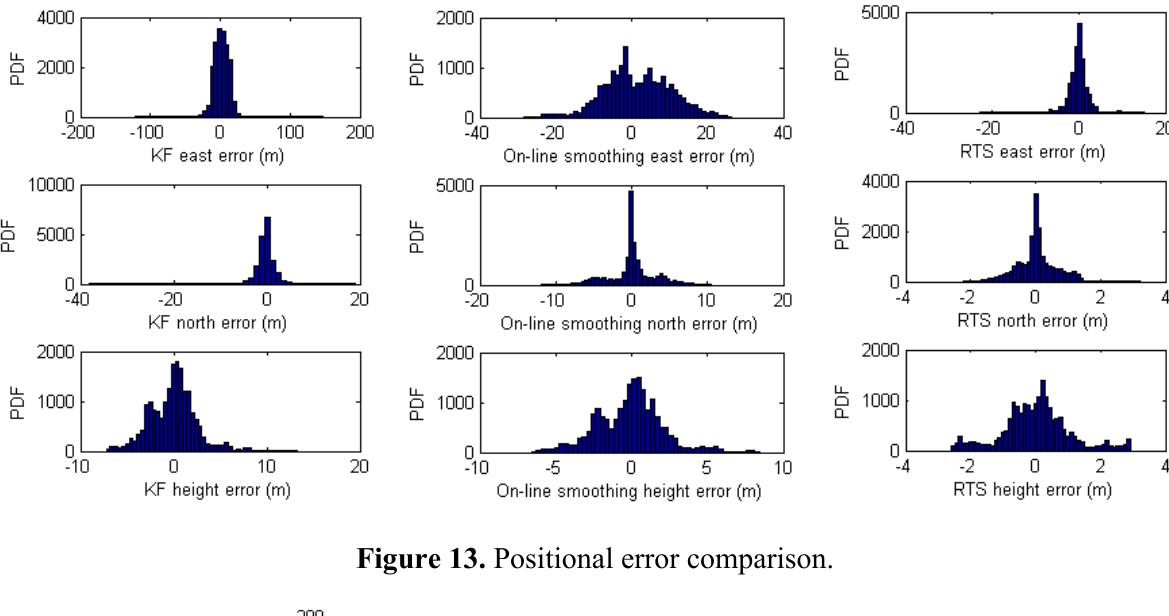
Figure 12. Positional error distributions of KF, on-line smoothing, and RTS smoother.